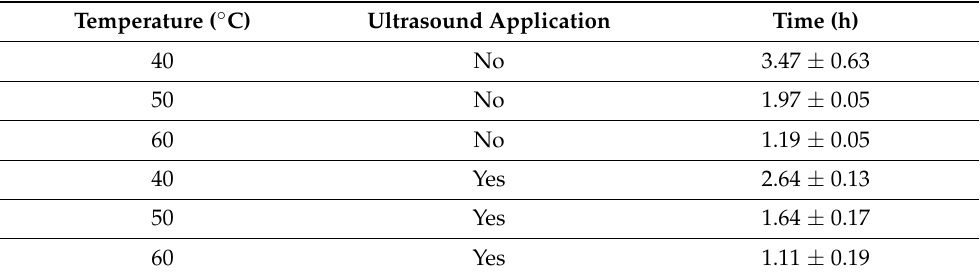
Table 1. Drying of henna leaves (1 m/s) at different temperatures, without and with ultrasound (21.7 kHz, 20.5 kW/m 3 ). Drying time needed to reach a final moisture content of 01 kg of water/kg of dry matter (mean ± SD).